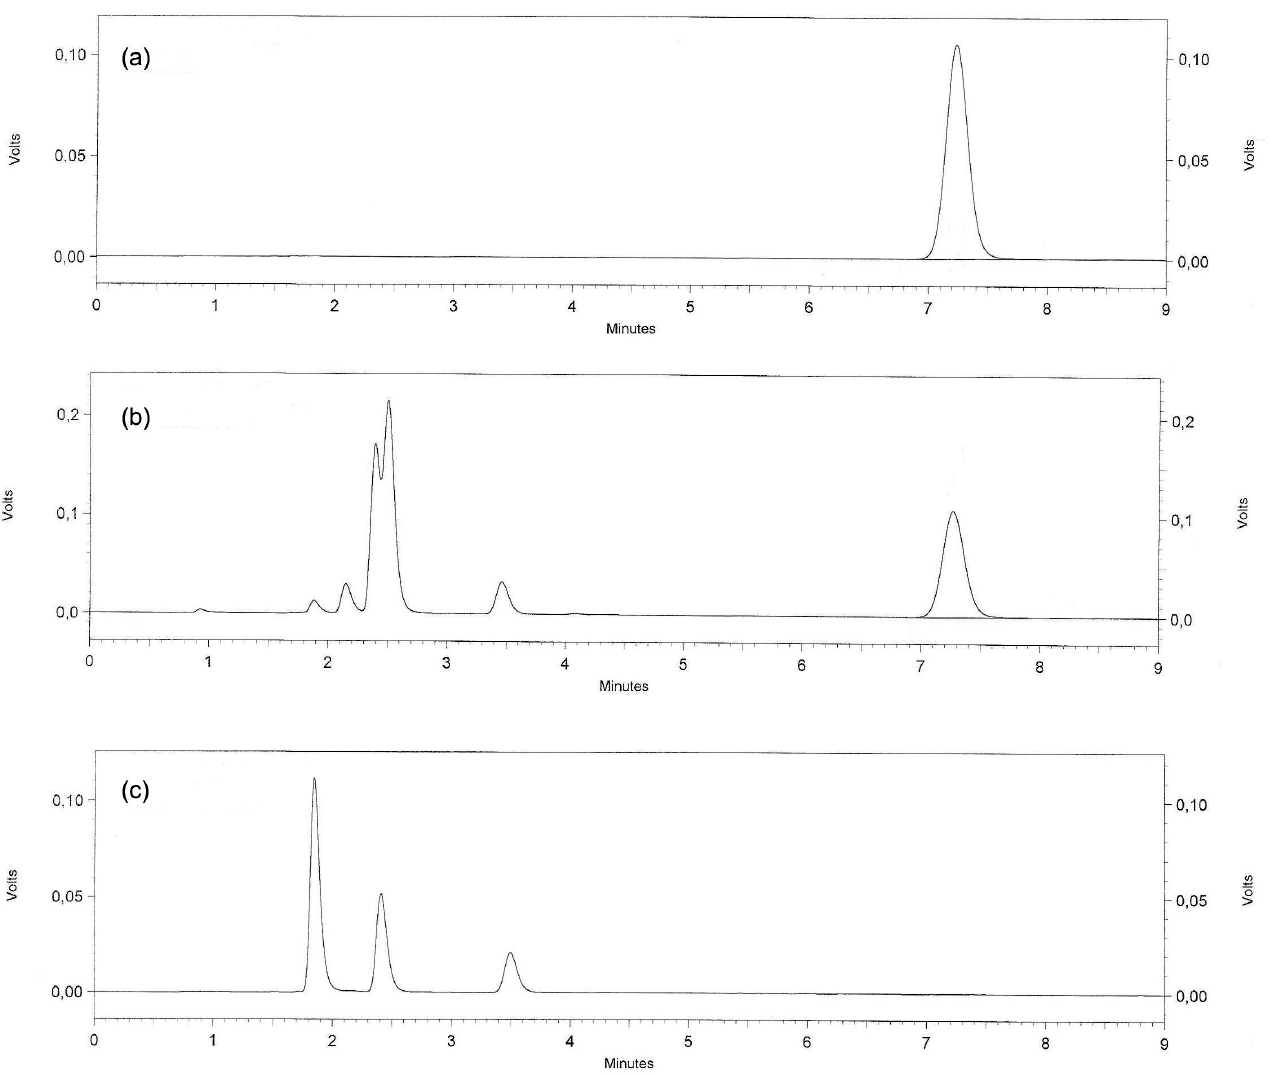
FIGURE 1 - Chromatograms corresponding to: (a) solution of DP reference substance, (b) oral suspension sample and (c) sample